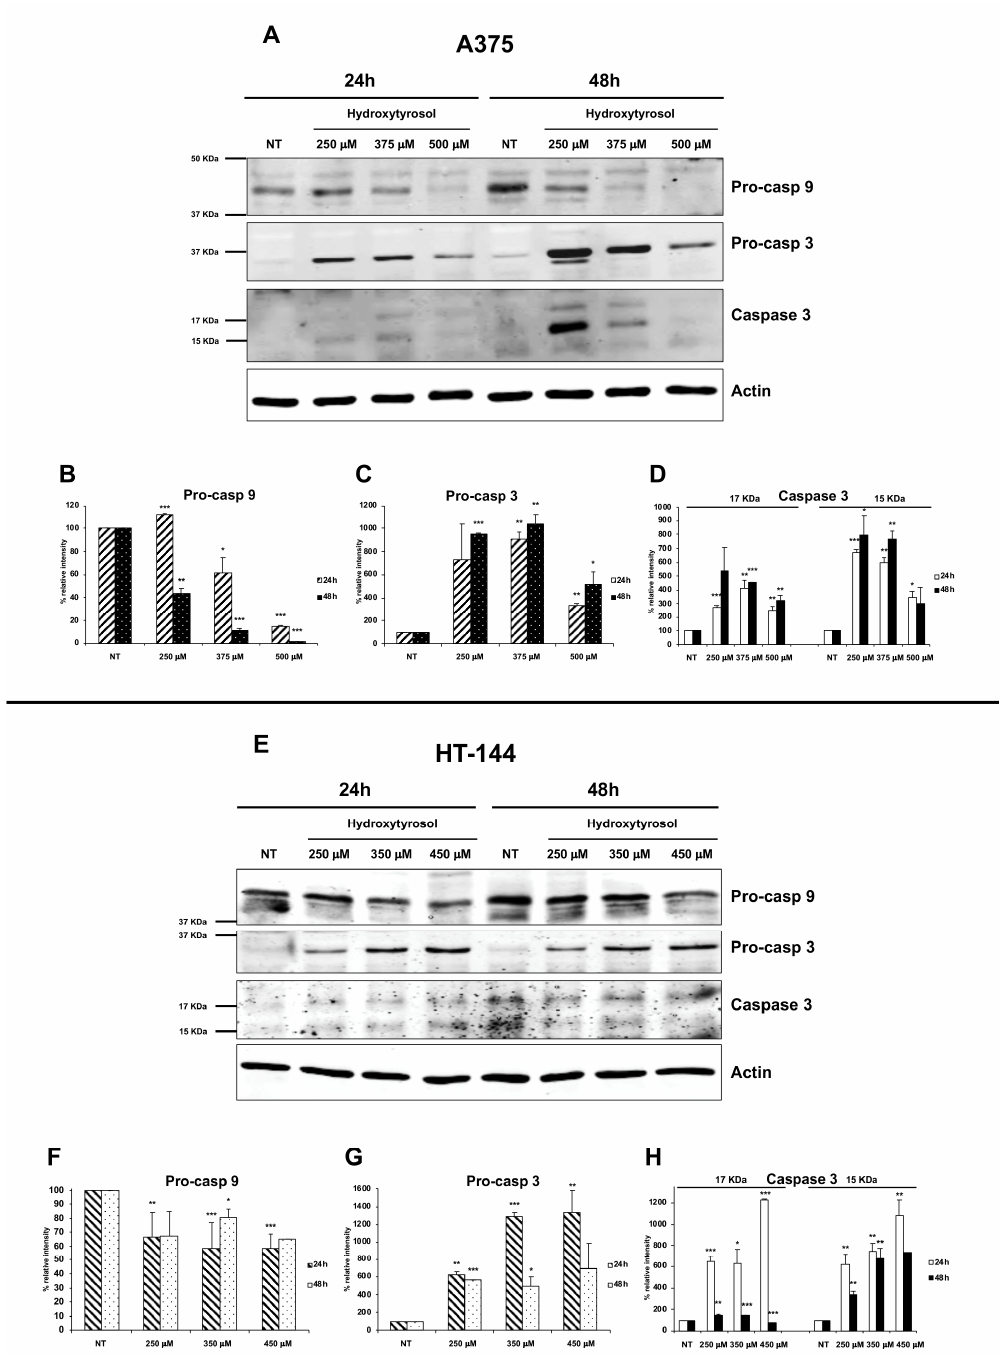
Figure 6. Expression of pro-caspase 9, pro-caspase 3, and caspase 3 in hydroxytyrosol treated melanoma cells. A375 cells ( A – D ) were treated with 250 µ M, 375 µ M, and 500 µ M of hydroxytyrosol and HT-144 cells ( E – H ) were treated with 250 µ M, 350 µ M, and 450 µ M of hydroxytyrosol for 24 h and 48 h. The expression of pro-caspase 9 ( A , E , upper panels, B , F ), pro-caspase 3 ( A , E , second panels, C , G ), and caspase 3 ( A , E , third panels, D , H ) was analysed in A375 and HT-144 cell lines in response to the treatment with hydroxytyrosol through western blot experiments. The equal protein loading was confirmed by the analysis of β -actin expression ( A , E , lower panels). The data are representative of several western blot experiments. The error bars indicate the standard deviation. Statistical significance was analysed by Student’s t -test: * p < 0.05 was considered significant; ** p < 0.01 highly significant; *** p < 0.001 very highly